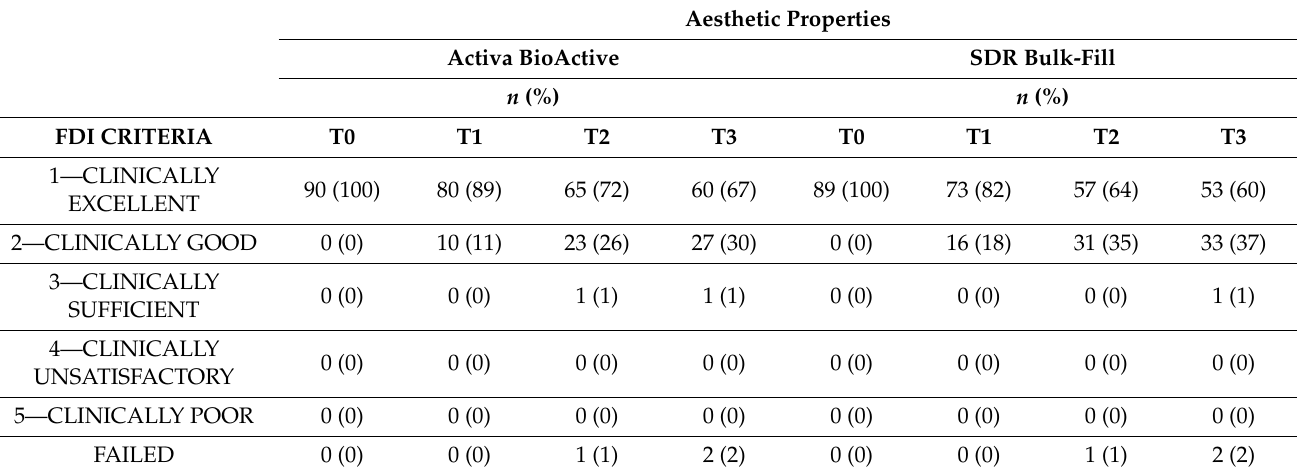
Table 4. Aesthetic properties evaluation based on FDI